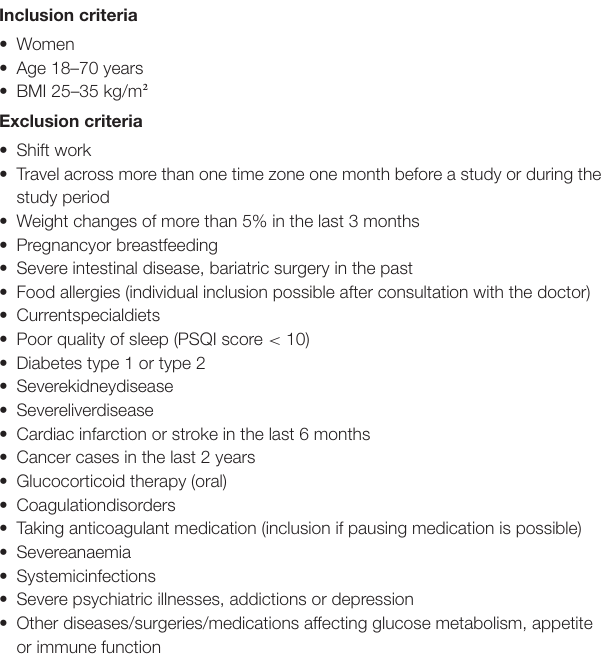
TABLE 2 | Inclusion and exclusion